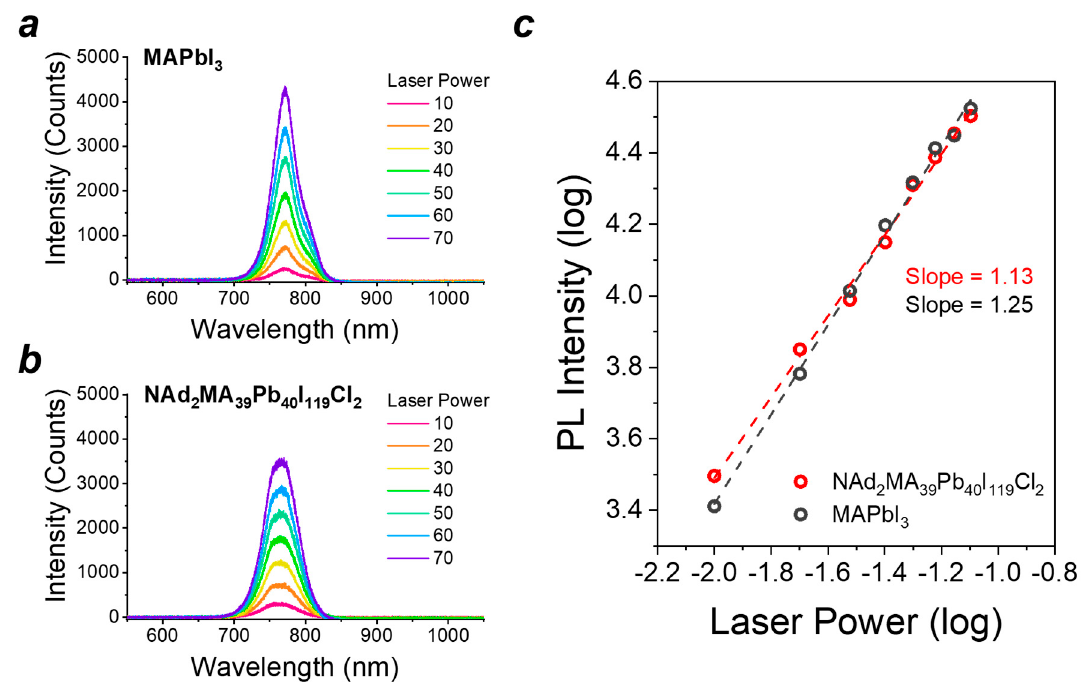
Figure 5. The evolution of the PL spectra of ( a ) MAPbI 3 and ( b ) NAd 2 MA 39 Pb 40 I 119 Cl 2 with increasing laser power (given in µW). ( c ) The PL intensity versus the laser power double logarithmic dependence was used to obtain the characteristic slope (S) values.